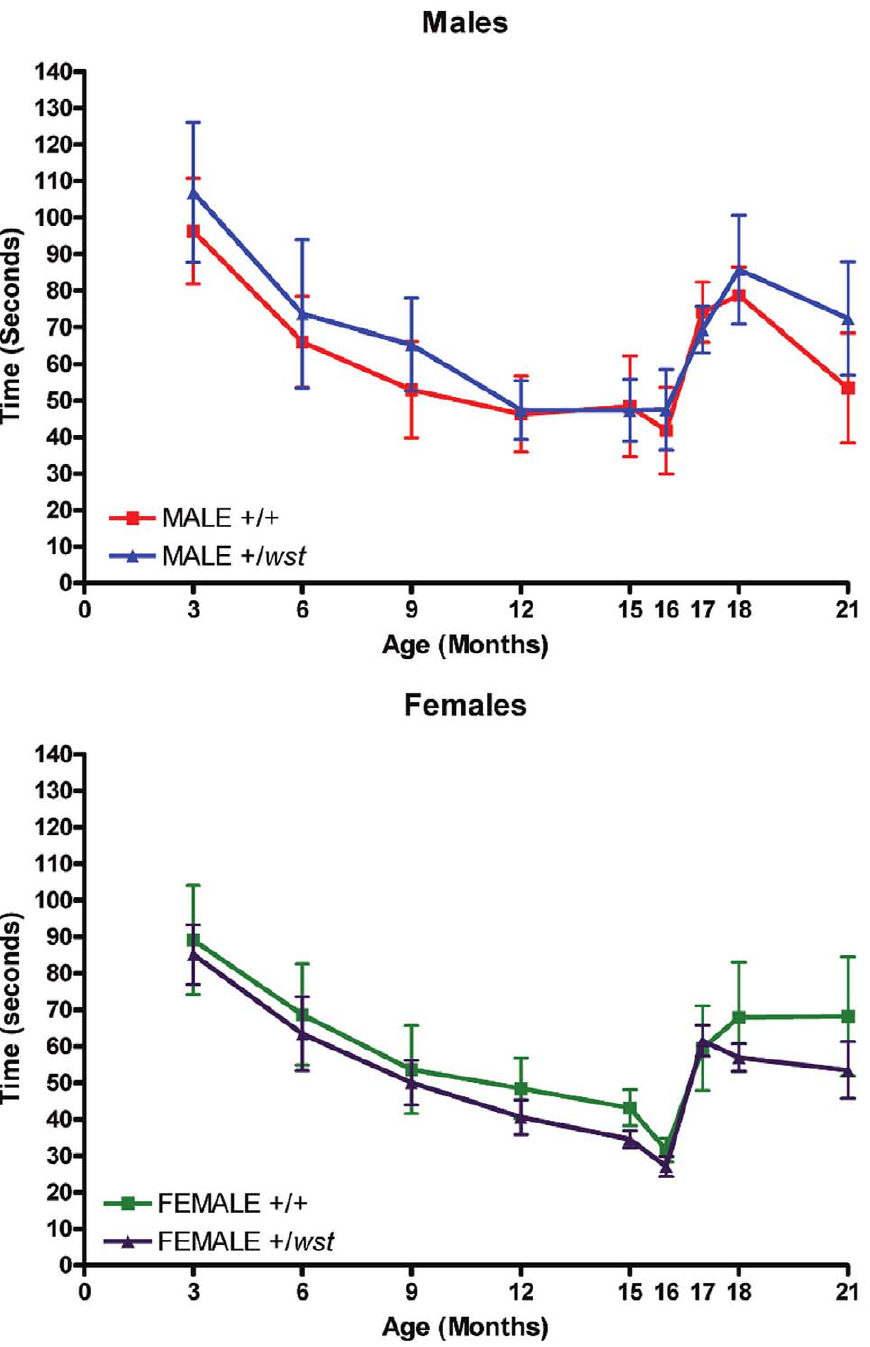
Figure 1. Rotarod analysis of aged mice. Mean times of latency to fall from the rotarod over the 21 months of the ageing study. WT indicates wild-type animals, HET indicates heterozygote animals. The upper graph shows data from the male groups and the lower graph shows data from the female groups. Error bars represent the standard error of the mean. doi:10.1371/journal.pone.0041917.g001 in Figure 1. No significant differences were observed between wild- types and heterozygotes of either gender between the ages of 3 and 21 months of age. The data were also analysed by normalising the mean times to body weight (data not shown) but again, no significant difference was found between groups. The performance of all four groups declined over the first 15 months, but then controls from 20 days in both the forelimbs only and in all four improved when monthly testing was introduced.